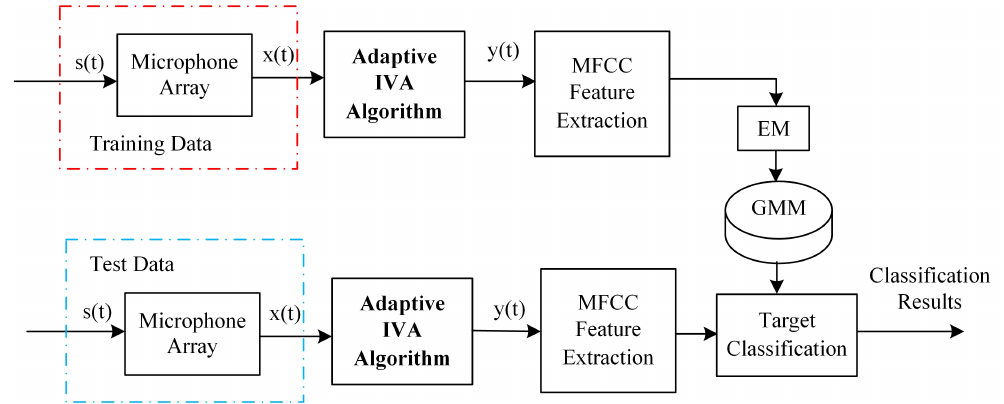
Figure 1. Diagram of the target classification system with the independent vector analysis (IVA)